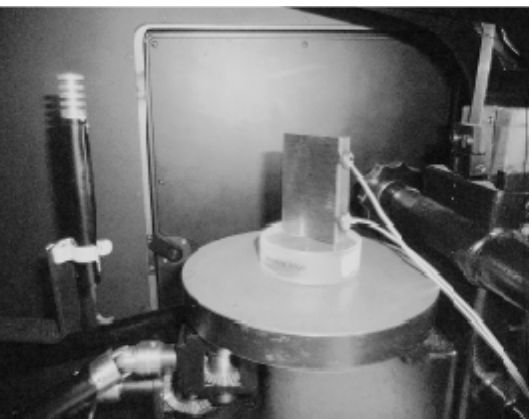
Fig. 2. Temperature measurement of the gauge block during calibration.